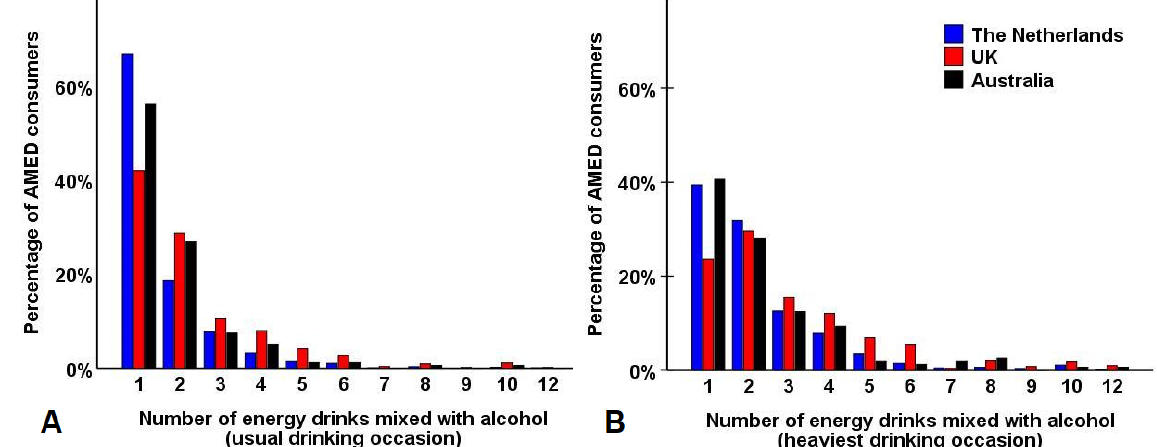
Figure 1. Number of energy drinks mixed with alcohol. Shown are the number of energy drinks mixed with alcohol on ( A ) a usual drinking occasion; ( B ) past month’s heaviest drinking occasion.